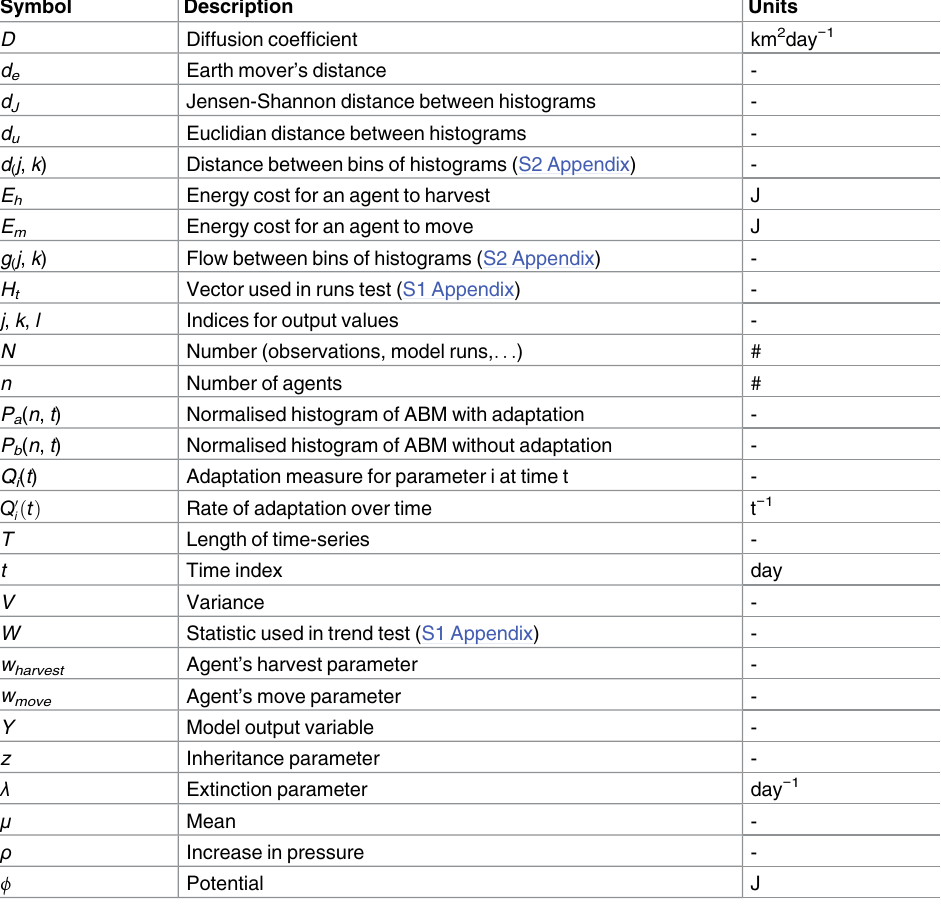
Table 1. Description of used symbols. Symbol Description Units D Diffusion coefficient km 2 day − 1 d e Earth mover’s distance - d J Jensen-Shannon distance between histograms - d u Euclidian distance between histograms - d ( j , k ) Distance between bins of histograms (S2 Appendix) - E h Energy cost for an agent to harvest J E m Energy cost for an agent to move J g ( j , k ) Flow between bins of histograms (S2 Appendix) - H t Vector used in runs test (S1 Appendix) - j , k , l Indices for output values - N Number (observations, model runs, ... ) # Number of agents # Normalised histogram of ABM with adaptation - Normalised histogram of ABM without adaptation - Adaptation measure for parameter i at time t - ð t Þ Rate of adaptation over time t − 1 Q 0 i Length of time-series - Time index day Variance - Statistic used in trend test (S1 Appendix)